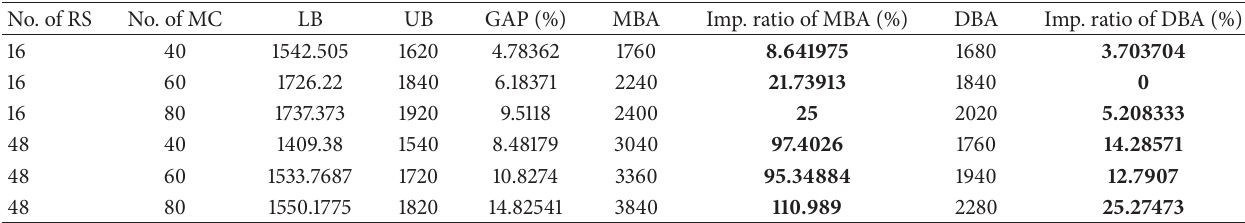
Table 8: Algorithm comparison (2BSs, random, 6.4km).